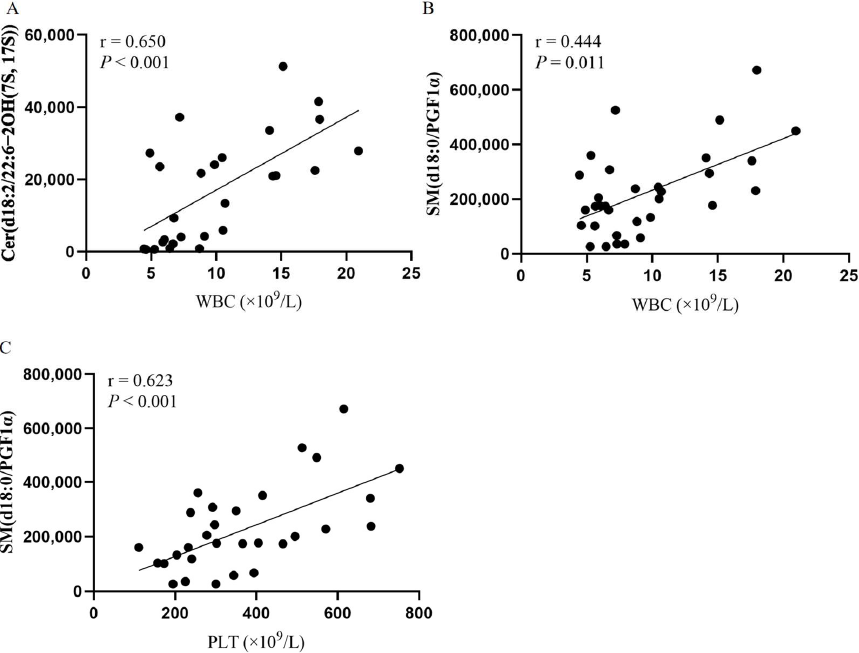
Figure 6. Correlation of Cer(d18:2/22:6-2OH(7S, 17S)) and SM(d18:0/PGF1α) with blood cell counts. Spearman’s correlation test. ( A ) Scatter plot of the correlation between Cer(d18:2/22:6-2OH(7S, 17S)) and WBC levels. ( B ) Scatter plot of the correlation between SM(d18:0/PGF1α) and WBC levels. ( C ) Scatter plot of the correlation between SM(d18:0/PGF1α) and PLT levels. 3.3. Potential Metabolic Biomarkers Relevant to the Prognosis of PV Patients